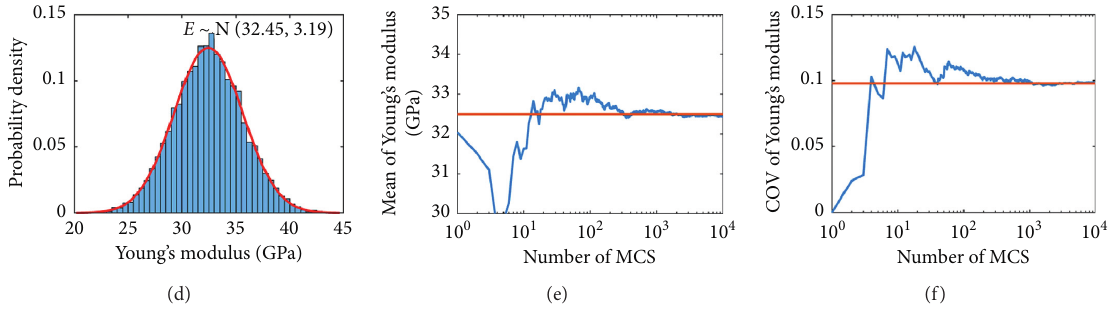
Figure 4: Histogram (a, d), mean (b, e), and COV (c, f) of the simulated random field properties within 10,000 MCSs. Top row and bottom row represent the results of mass density and Young’s modulus, respectively.